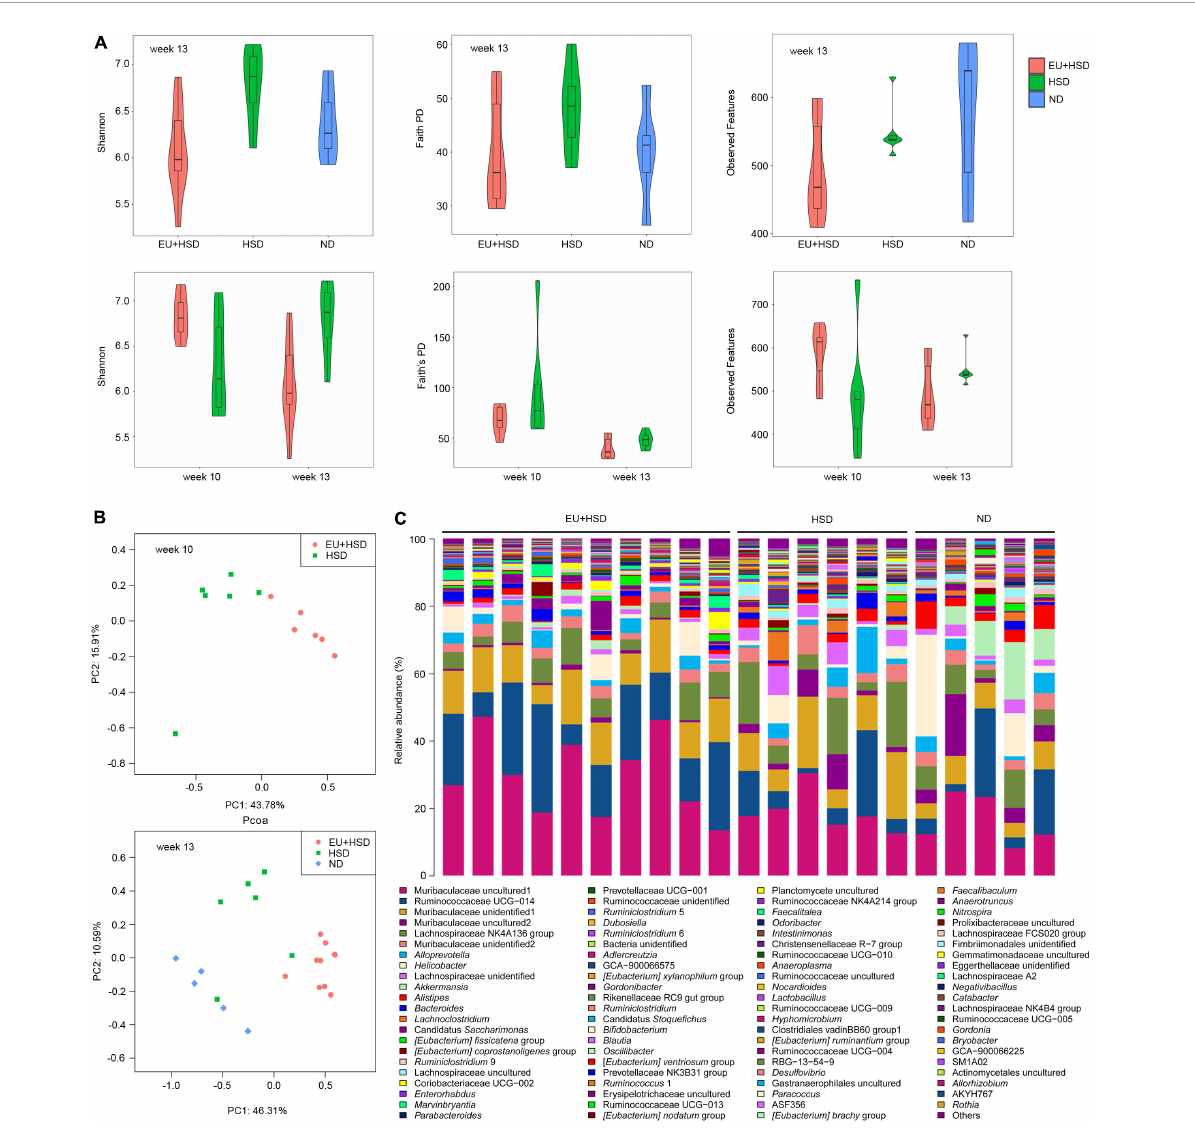
FIGURE3 EU influences gut microbiota diversity and composition in hypertensive mice subjected to a high-salt diet (HSD) and L-NAME treatment. (A) Shannon index, Faith’s PD, and Observed Features in the EU + HSD, HSD, and ND groups in week 13 and the EU + HSD and HSD groups in weeks 10 and 13. (B) Principal co-ordinates analysis of bacterial communities in the EU + HSD and HSD groups in week 10 and in the EU + HSD, HSD, and ND groups in week 13. PC1: principal component 1; PC2: principal component 2. (C) Relative abundances of dominant genera ( > 0.03%) in the EU + HSD, HSD, and ND groups in week